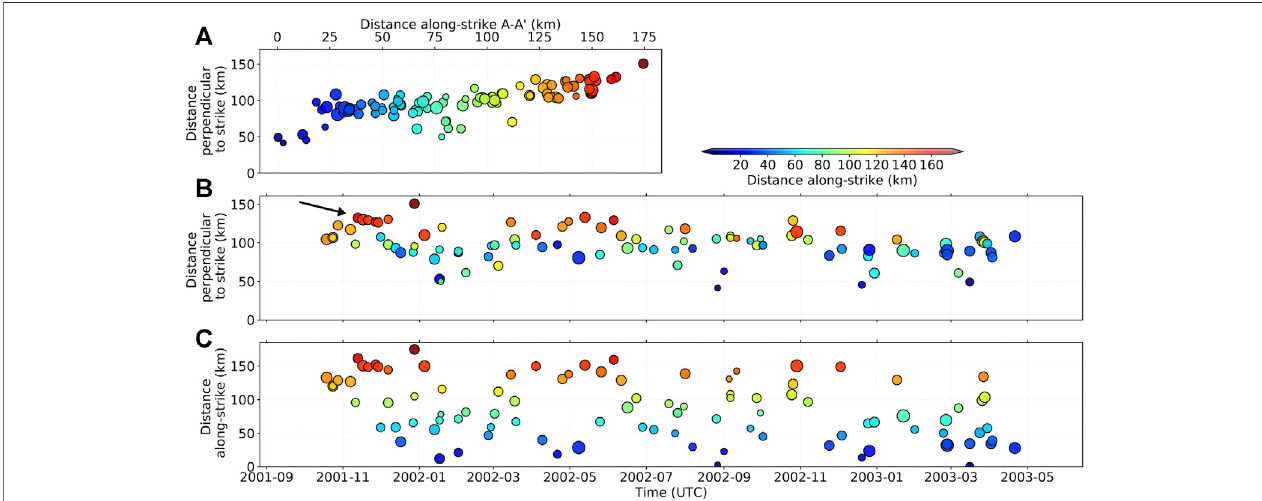
FIGURE 8 | Graph visualizing the space and time evolution of the hypoDD relocated seismicity along strike and perpendicular to Cluster 1. Circles are colored according to the distance along strike of cross-section A – A ’ . (A) Rotated map view of seismicity along cross-section A – A ’ (strike) and B – B ’ (perpendicular to strike). (B) Distance perpendicular to strike vs. time. (C) Distance along strike vs. time. Figure format is adapted from Shelly et al. (2007). The black arrow highlights the November 17, 2001 sequence.